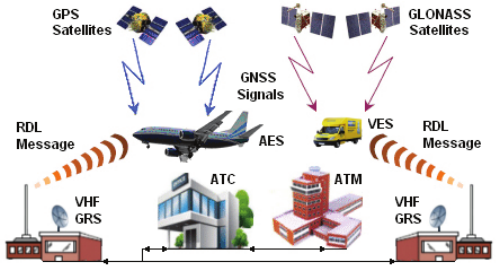
Figure 2. Aeronautical VDL Network – Courtesy of Manual: by Ilcev